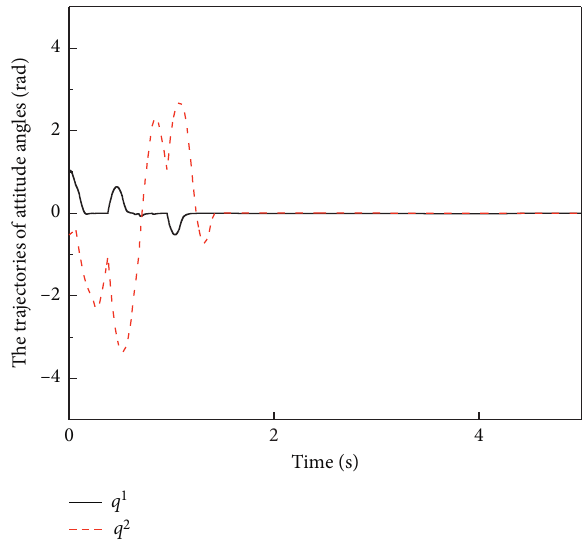
Figure 11: The trajectories of attitude angles (rad).